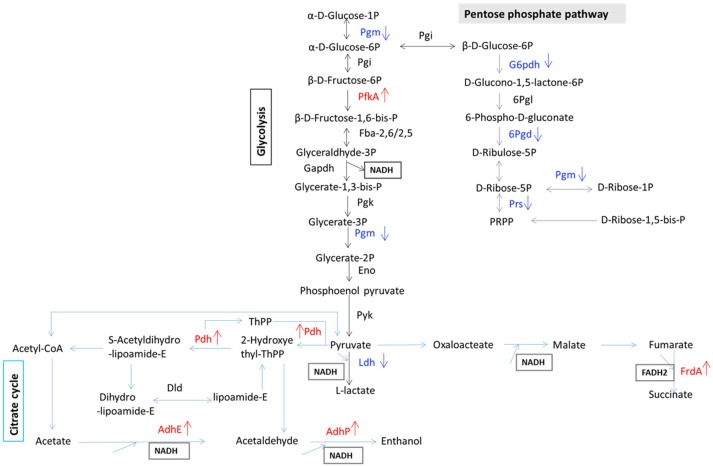
Schematic representation of SS2 metabolic pathways differentially regulated in carbohydrate metabolism. Differentially expressed proteins are involved in glycolysis, citrate cycle, and pentose phosphate pathway. Red color, up-regulated proteins; blue color, down-regulated proteins.